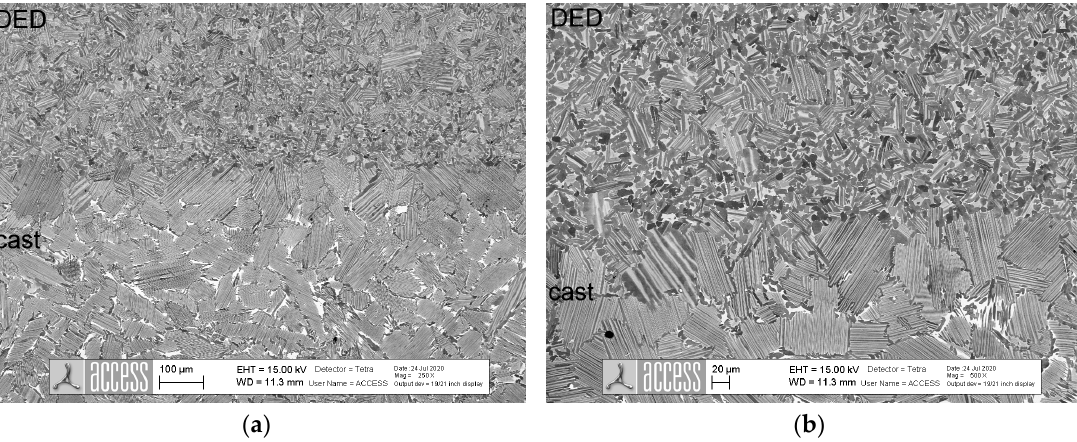
Figure 4. SEM images of the transition zone between cast and DED material in heat-treated condition